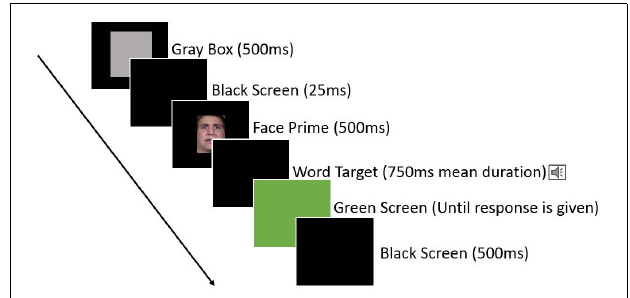
FIGURE 4 | Illustration of an individual trial for Experiment 2, with faces priming the categorization of target emotion